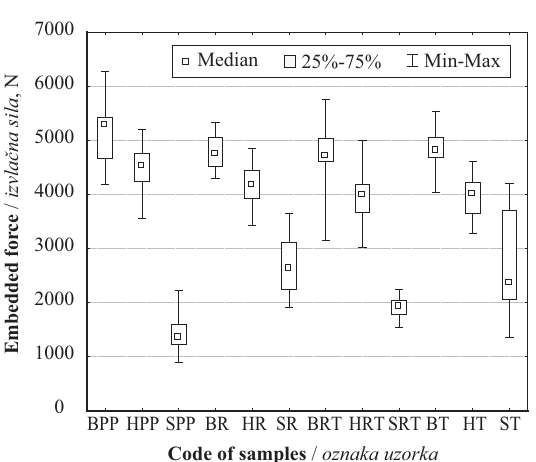
Figure 3 Infl uence of wood species and cross-section on embedded